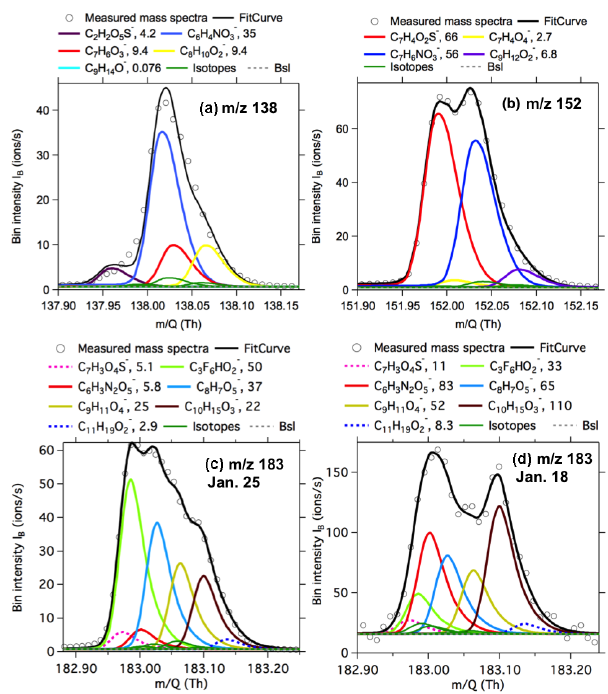
Figure 2. High-resolution peak fitting to the averaged mass spectra of acetate ToF-CIMS for m/z 138 (a) , m/z 152 (b) , and m/z 183 (c) on 25 January 2014 and m/z 183 (d) on 18 January 2014 during UBWOS 2014. The dark-green lines indicate the calculated isotope signals from lower